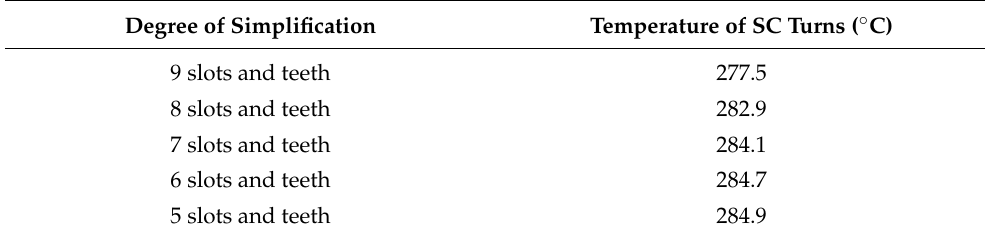
Table 6. Temperature under different degree of